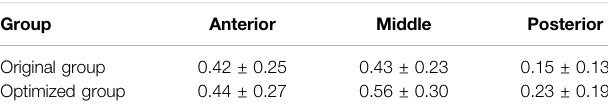
TABLE 3 | Average stress of the anterior, middle, and posterior parts in the proximal medial tibia (mean ± SD, MPa). Group Anterior Middle Posterior Original